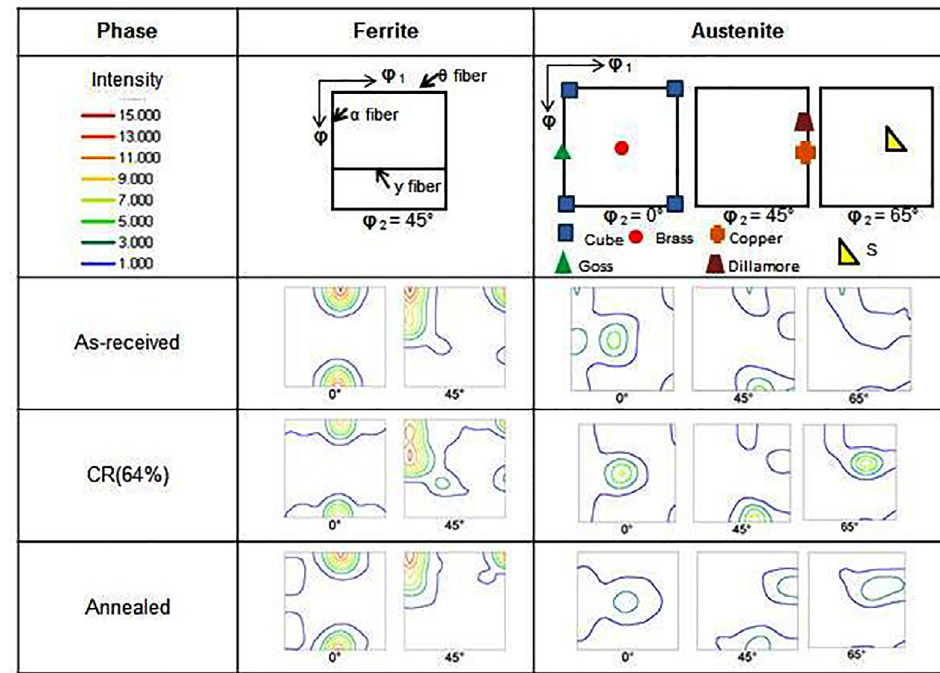
Figure 5. Crystallographic microtexture of duplex stainless steels S32205 of the samples as received, cold rolled and annealed